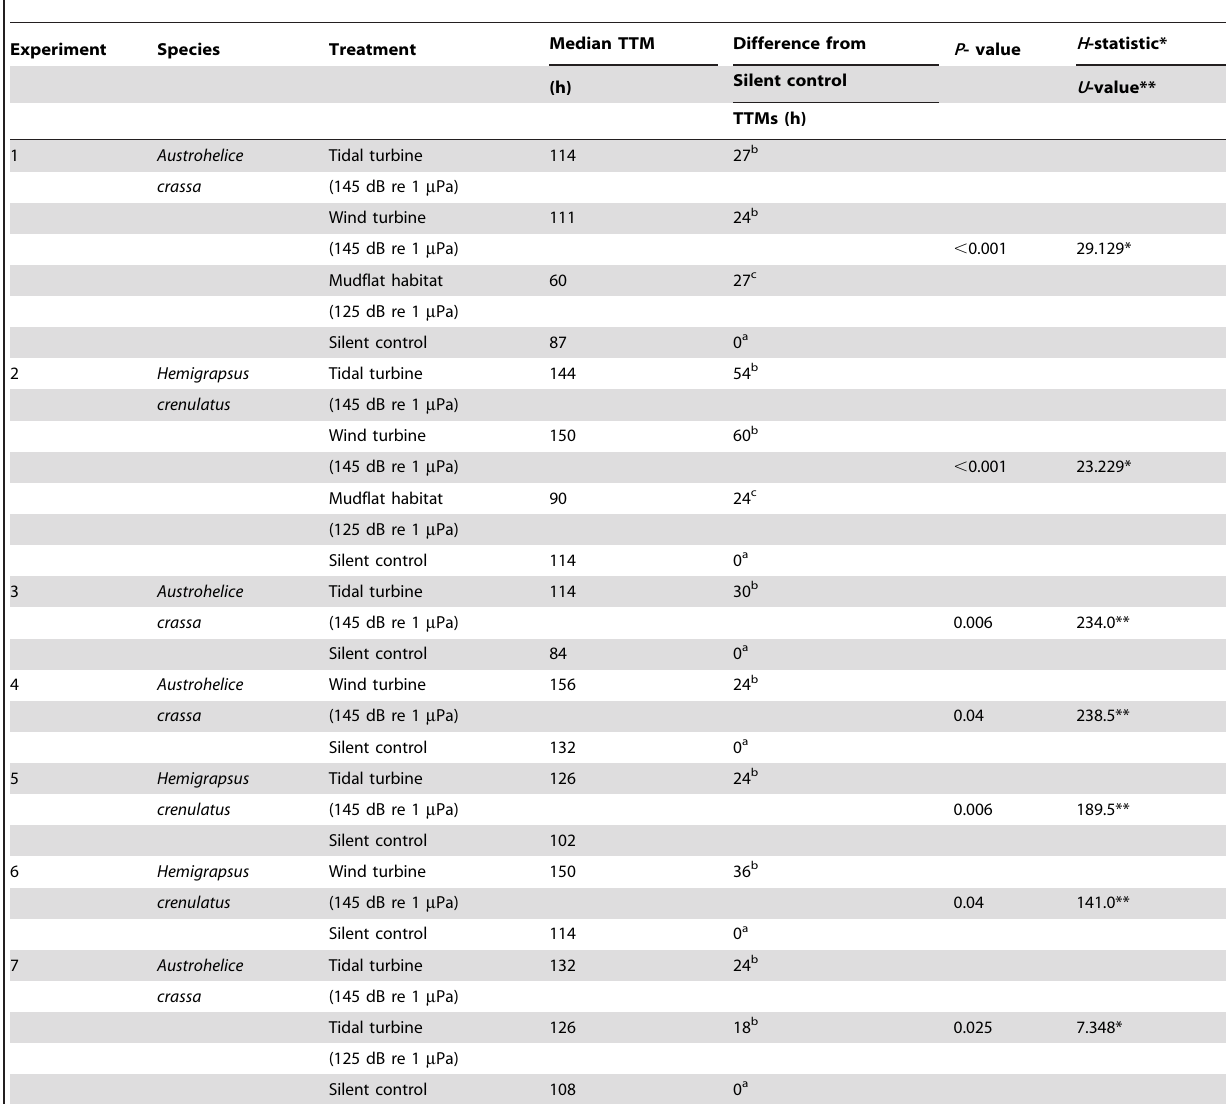
Table 2. Comparisons among median TTM for each treatment for two estuarine crab species from seven individual sound exposure